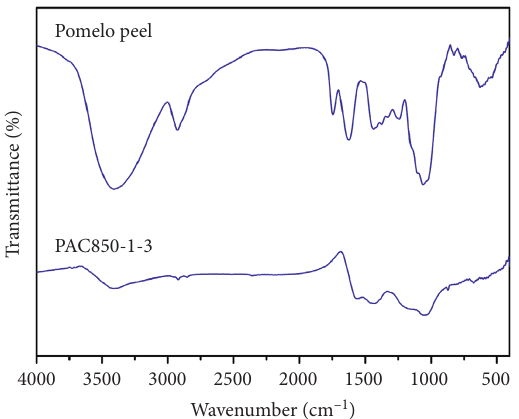
Figure 4: FTIR spectra of pomelo peel and